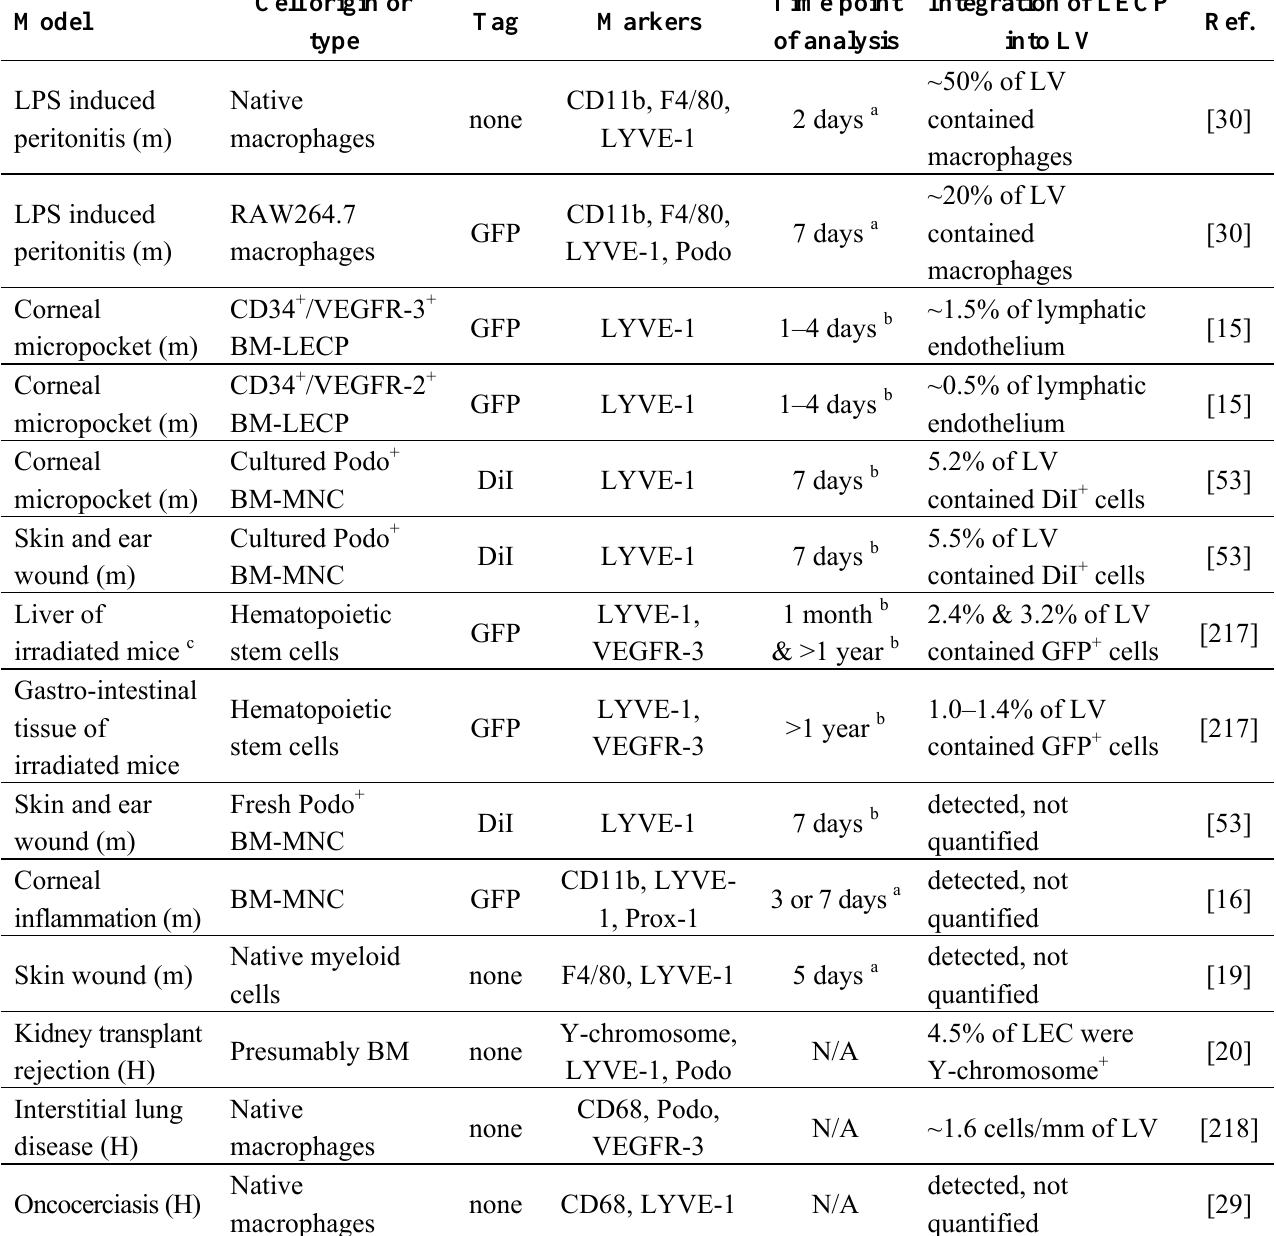
Table 4. LECP incorporation into inflamed lymphatic vessels.